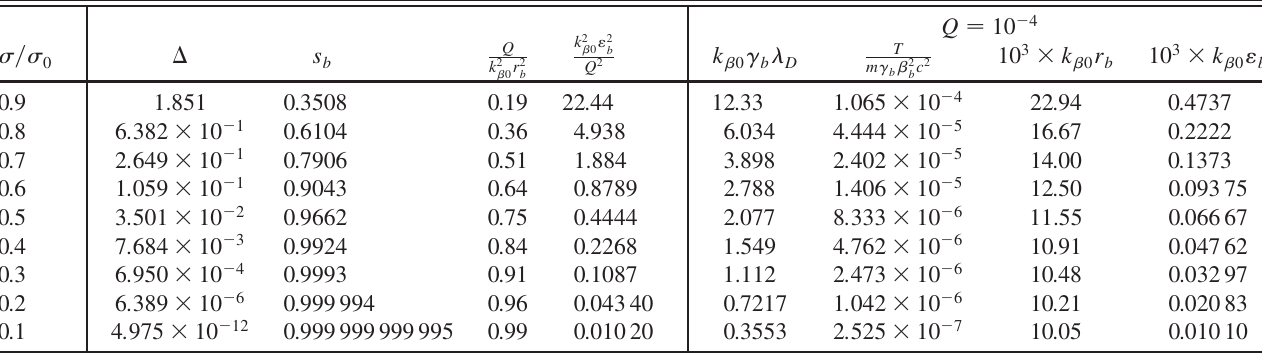
TABLE V. Dimensionless thermal equilibrium parameters in Fig. 19 calculated for specified (cid:3)=(cid:3) (cid:5) 2 c 2 Þ , and k " T= ð m(cid:8) are evaluated for Q ¼ 10 (cid:1) 4 , and all other quantities are independent of Q . b (cid:5) 0 b b